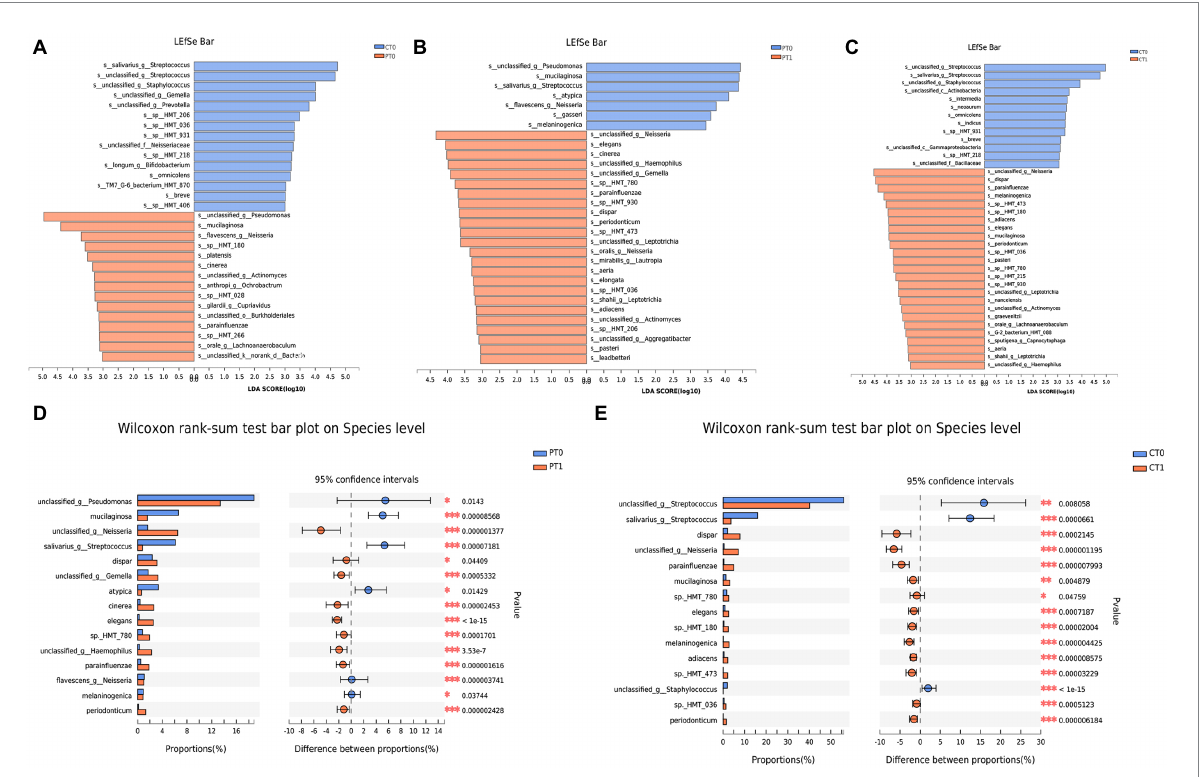
FIGURE 3 Variation in microbial composition. (A–C) Contrast of the relative bacterial abundances on the species level based on the LDA effect size (LEfSe) algorithm (LDA score [log10] >3). (D,E) Microbiome alterations at the species level along with two lower primary central incisors teeth eruption in preterm and full-term groups based on Wilcoxon rank-sum test. * p < 0.05, ** p < 0.01, and *** p <